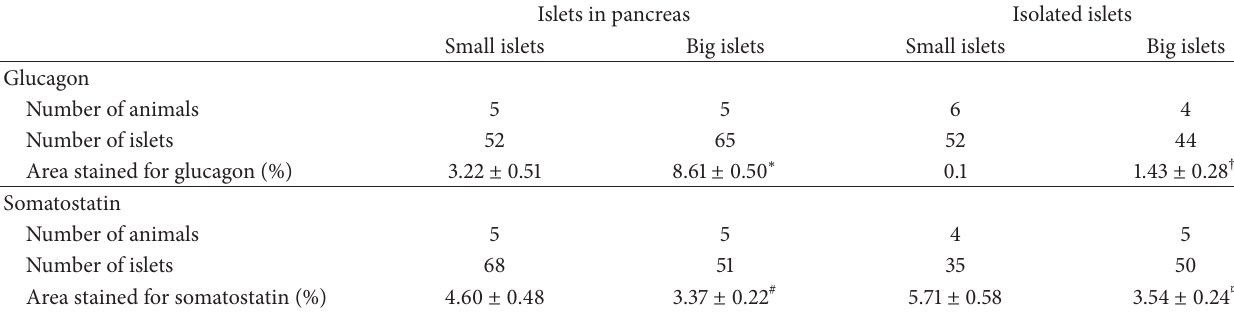
Table 1: Proportions of 𝛼 - and 𝛿 -cells in small and big islets. Areas stained for glucagon and somatostatin in the largest cross section of small ( < 60 𝜇 m) and big ( > 100 𝜇 m) islets. The data refer to observations made in paraffin sections of pancreas and isolated islets. All values are given as means ± SEM. ∗ 𝑃 < 0.001 compared with small islets stained for glucagon in the pancreas. # 𝑃 < 0.05 compared with small islets stained for somatostatin in the pancreas. † 𝑃 < 0.05 compared with small isolated islets stained for glucagon. ¤ 𝑃 < 0.001 compared with small isolated islets stained for somatostatin. Islets in pancreas Isolated islets Small islets Big islets Small islets Big